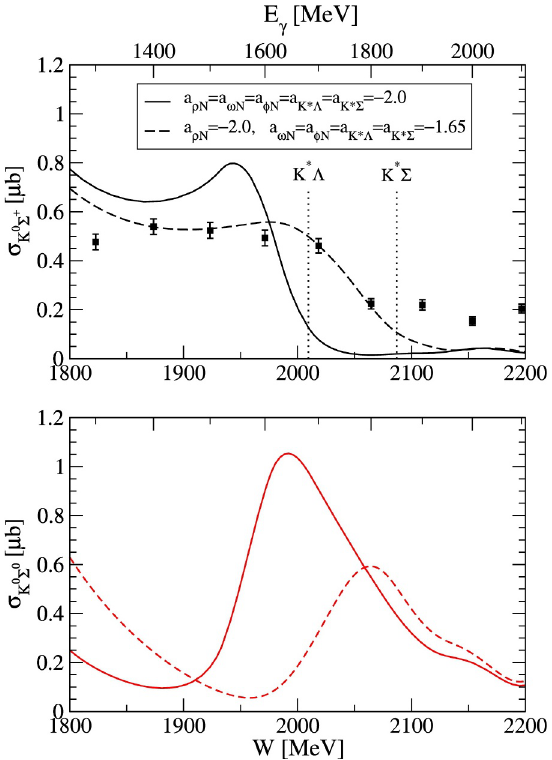
Figure 1. A prediction of the cross section of γ p → K 0 Σ + (upper plot) and γ n → K 0 Σ 0 (lower plot) is shown as solid line. The dotted line parameters were fitted to the data (black points [1]). Figure taken from Ref. [6].